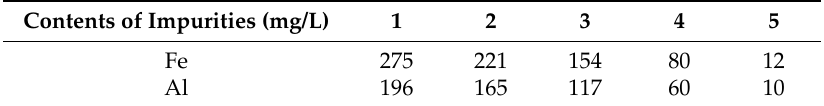
Table 1. The content of the impurities after multiple stages of different extraction and